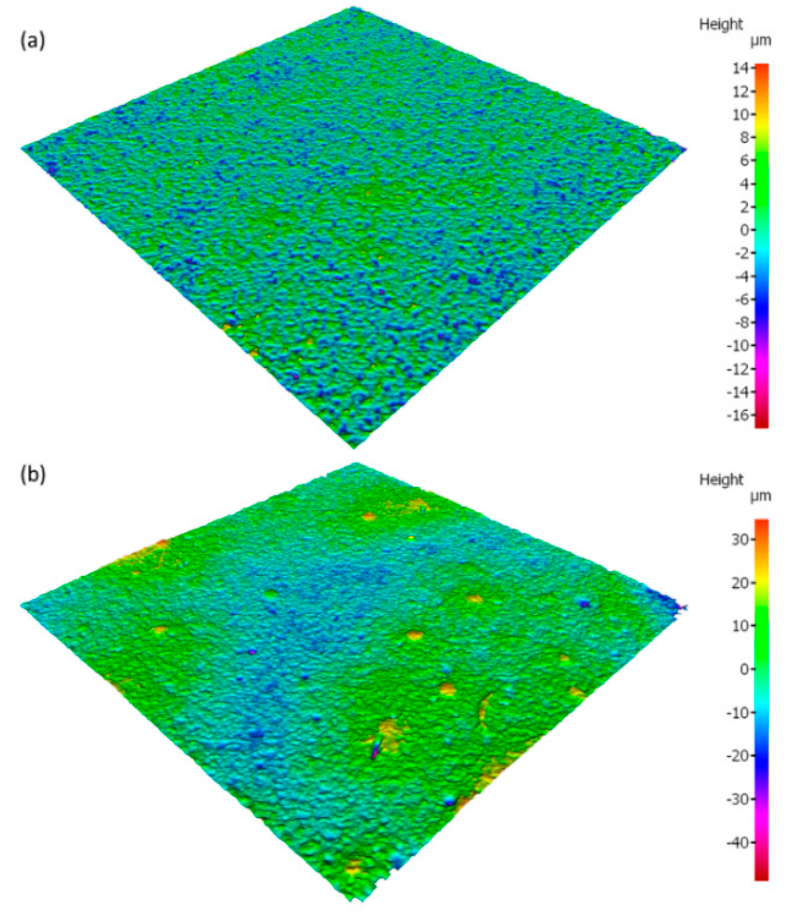
Figure 3. Infinite focus micrographs for ( a ) acrylic coating, and ( b ) acrylic coating containing microcapsules.